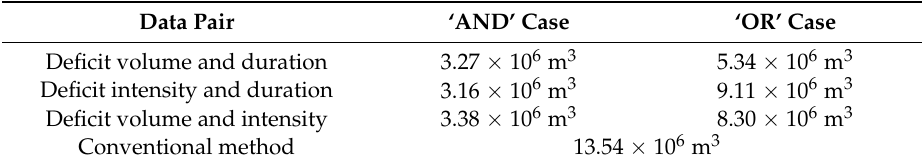
Table 6. Vulnerabilities estimated for three different pairs of two variables and two cases of calculating the occurrence probability, i.e., ‘AND’ and ‘OR’